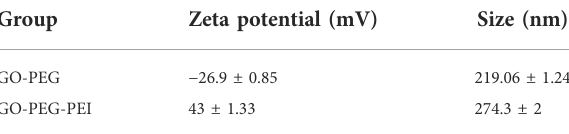
TABLE 1 Zeta potentials and average sizes of GO-PEG and GO- PEG-PEI.